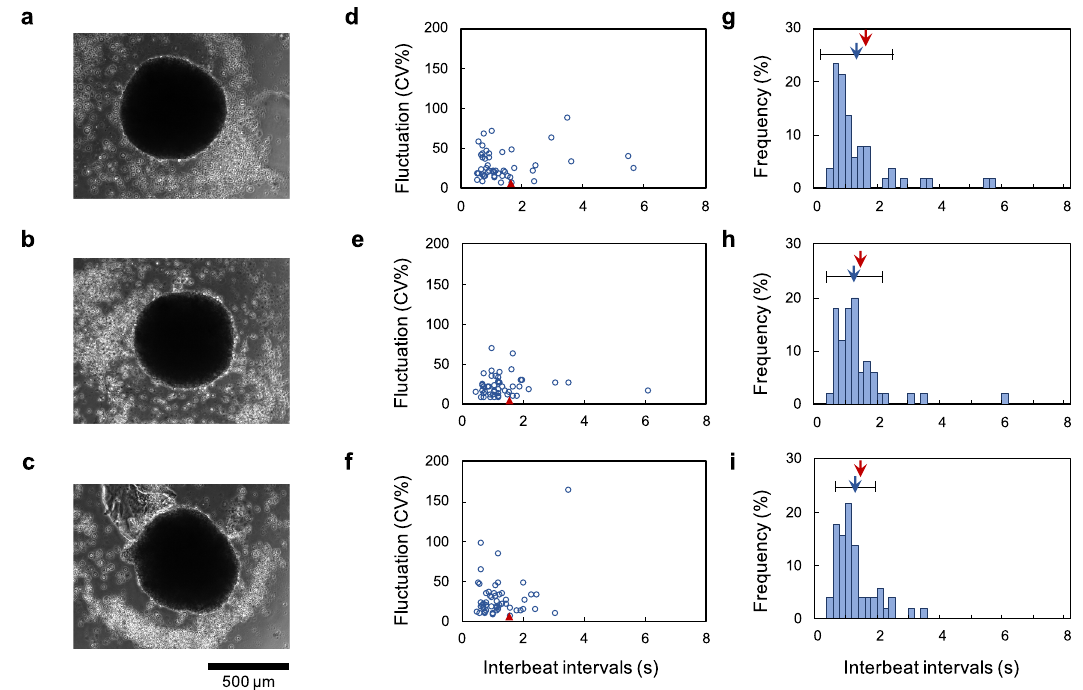
Figure 4. Distribution of IBIs and fluctuation of IBI distribution of the hES cardiomyocyte clusters and their constituent cells. ( a )–( c ): Micrographs of hES cardiomyocyte clusters. ( d )–( f ): Distribution of IBIs and the CV of IBIs in the clusters ( a )–( c ) and isolated constituent cells from each cluster (n=50 from among re-cultivated 1.0 × 10 3 cells ). These plots ( d )–( f ) correspond to each cluster ( a )–( c ). The red filled triangles indicate the cardiomyocyte clusters, and the blue open circles indicate constituent cardiomyocytes of each cluster. Each cluster was measured 2 days after the beating started. Single cardiomyocytes were isolated from each cluster by trypsinization. IBIs of single constituent cardiomyocytes were measured 3 days after their isolation. Median and 95% confidence interval of single cardiomyocytes were 0.971 s and 0.825–1.25 s ( d ), 1.19 s and 1.00–1.28 s ( e ), and 1.12 s and 0.844–1.22 s ( f ), respectively. ( g )–( i ): Histograms of IBIs of each cluster and its isolated constituent cells. The blue filled bars indicate the ratio of frequency for single constituent cardiomyocytes; the blue arrows and error bars indicate the mean IBIs and SDs, and the red arrows also indicate the mean IBIs of clusters.